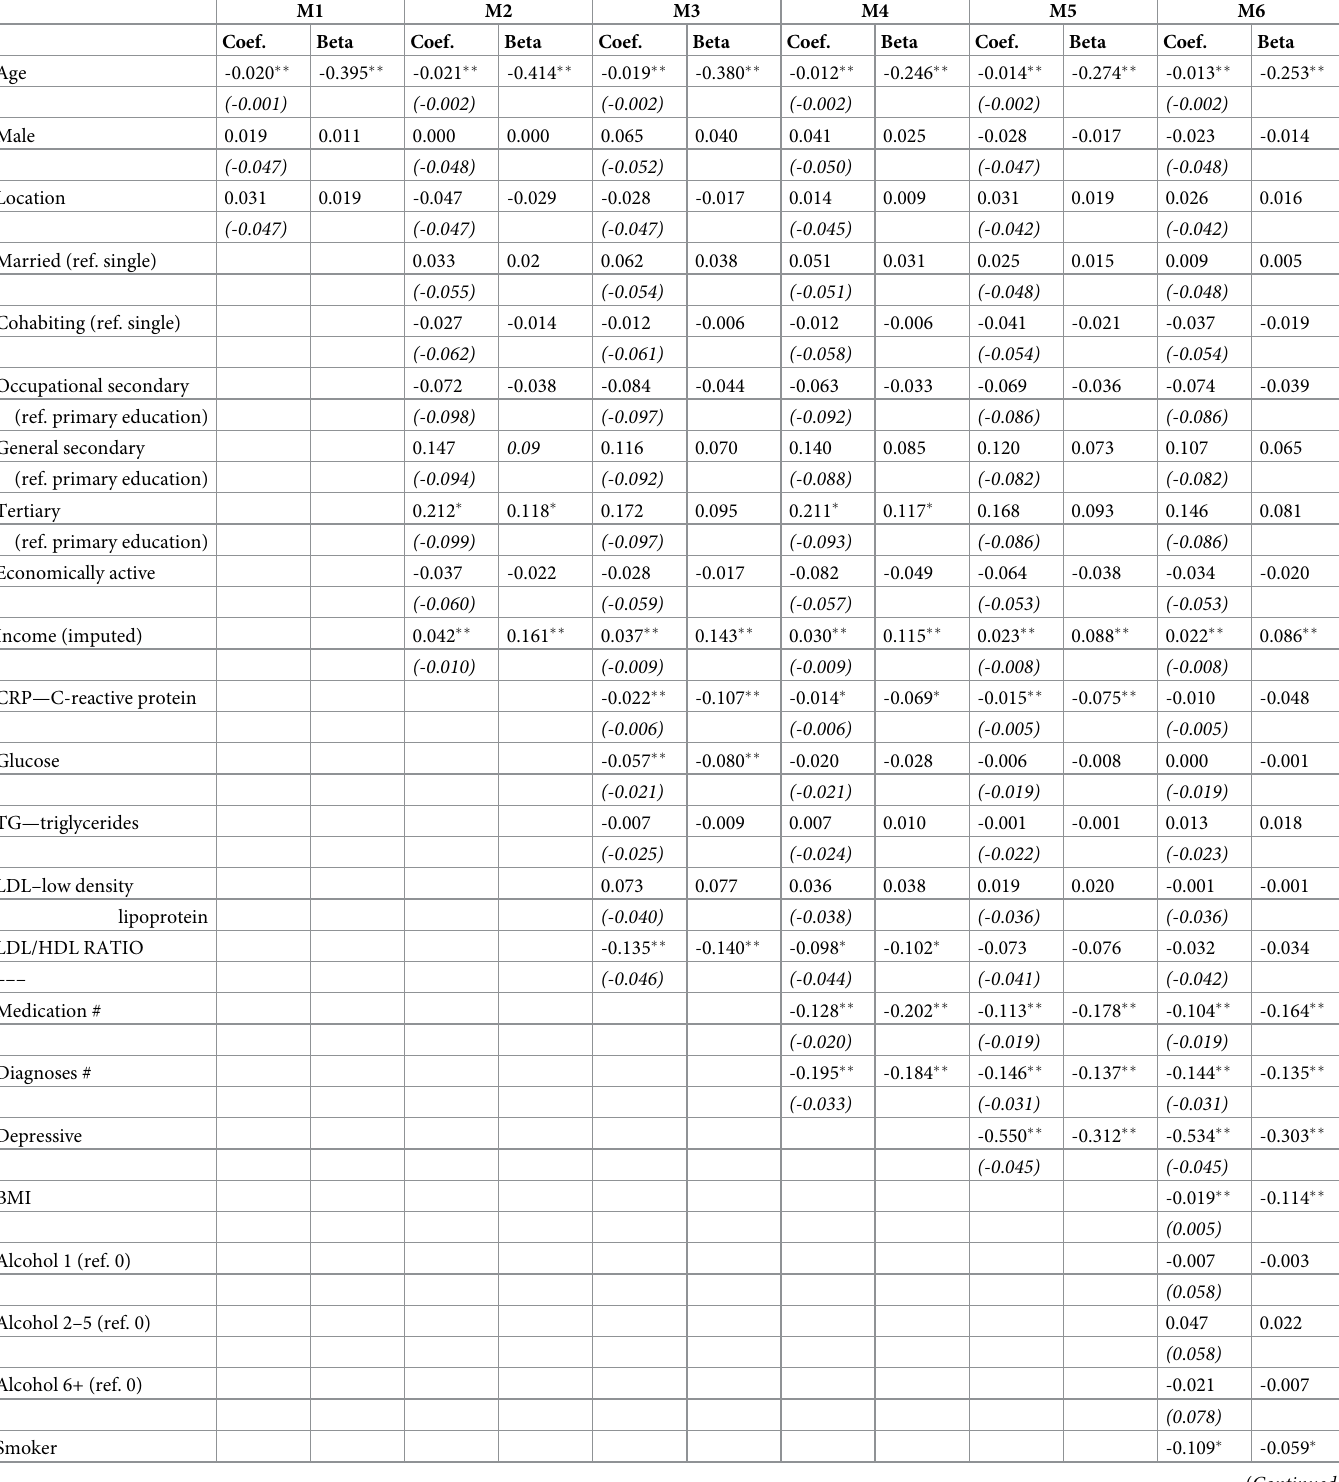
Table 4. Results of ordinary least squares (OLS) regression models with dependent variable SRH, displaying regression coefficients, standardized coefficients (beta), standard errors (in parentheses), and significance level. M1 M2 M3 Coef. Coef. Coef.